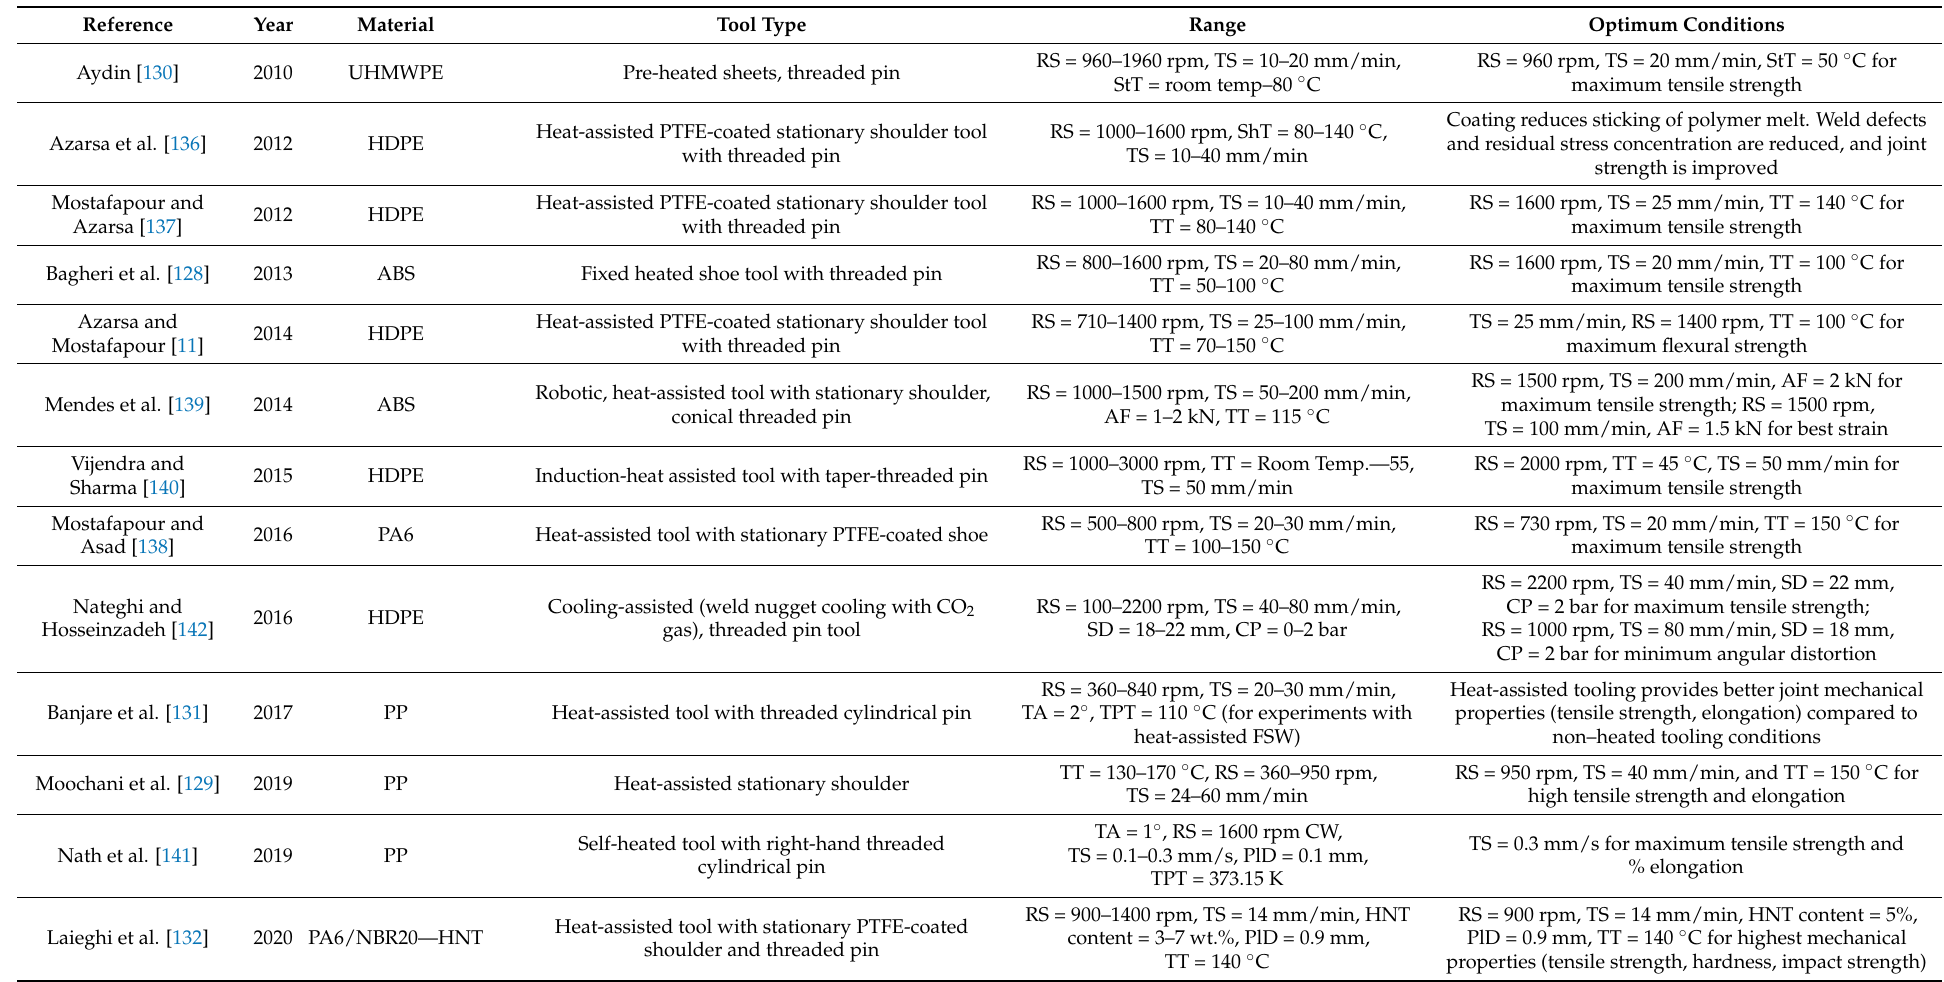
Table 4. Heat-assisted butt-joint friction stir welding of thermoplastic polymers and polymer